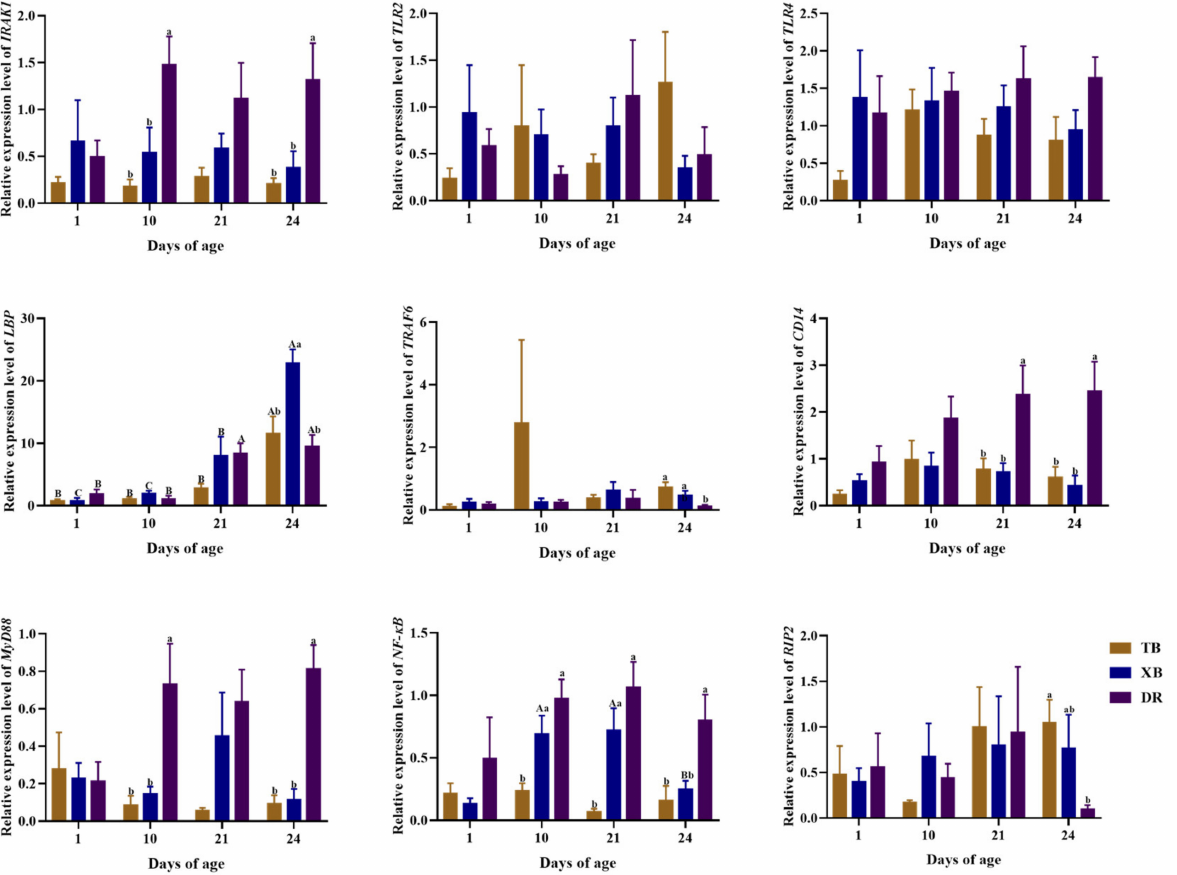
Figure 5. Changes in expression levels of ileal genes related to TLR-MyD88-NF- κ B signaling